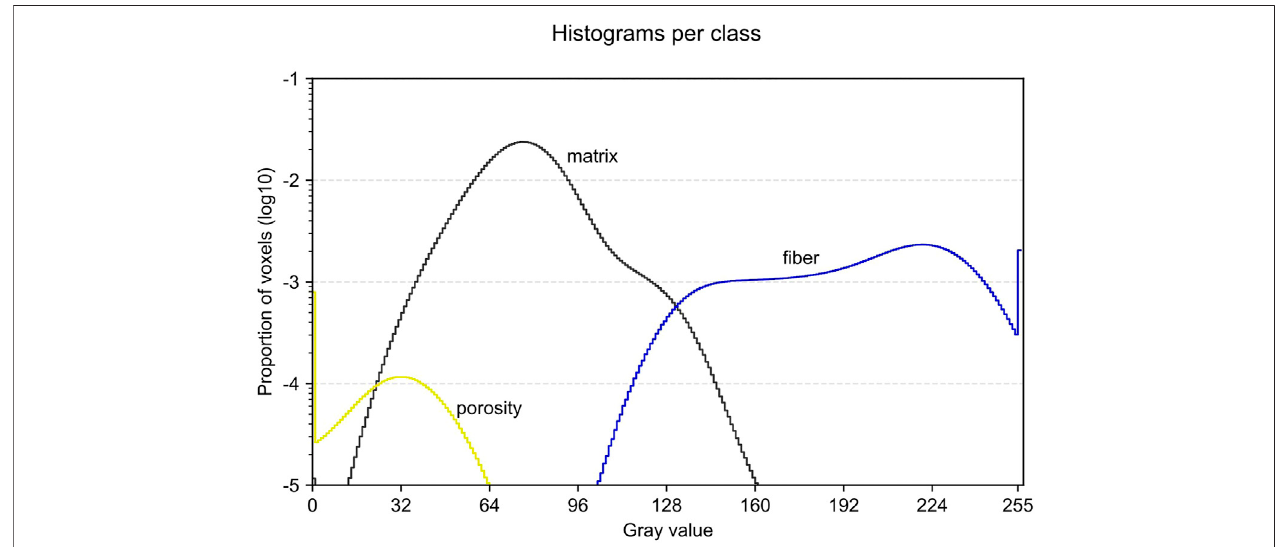
FIGURE 7 | Glass fi ber-reinforced Polyamide 66 gray value (normalized) histograms (one per class). The histogram is normalized globally, i.e., a bin ’ s value is the proportion of voxels out of all the voxels (all classes confounded). The superposition of the classes ’ value ranges make it impossible to segment the image with a threshold on the gray values.